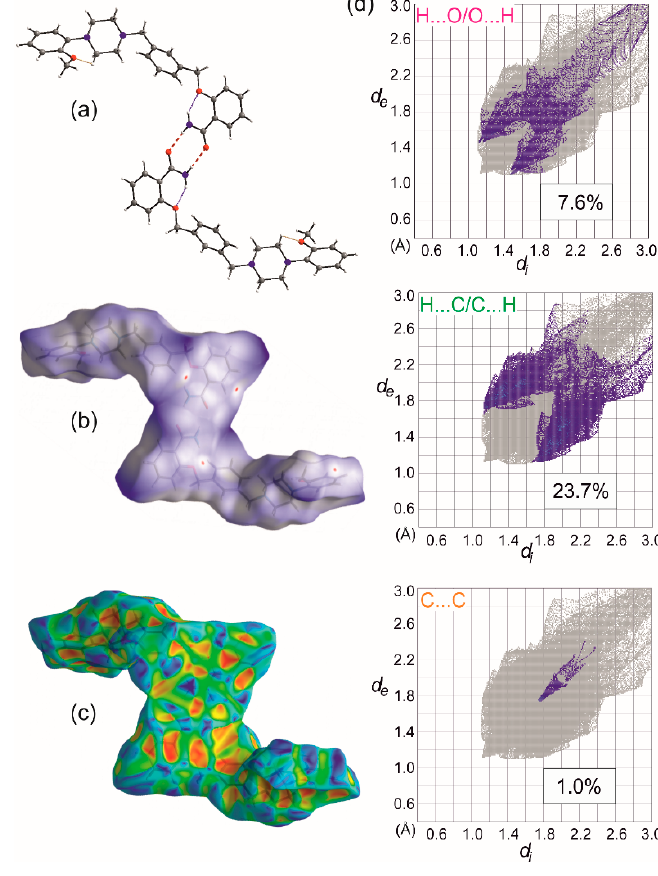
Figure 6. Basic dimeric R 22 (8) motif formed by N-H…O bonds (red dashed lines) and intramolecular interactions leading to S (6) motifs (dotted lines). ( a ). Hirshfeld surface calculated for the dimer with depicted d norm ( b ), and shape index properties ( c ), and selected decomposed fingerprint plots showing characteristic features of C-H…O, C-H… π and π … π interactions ( d ).